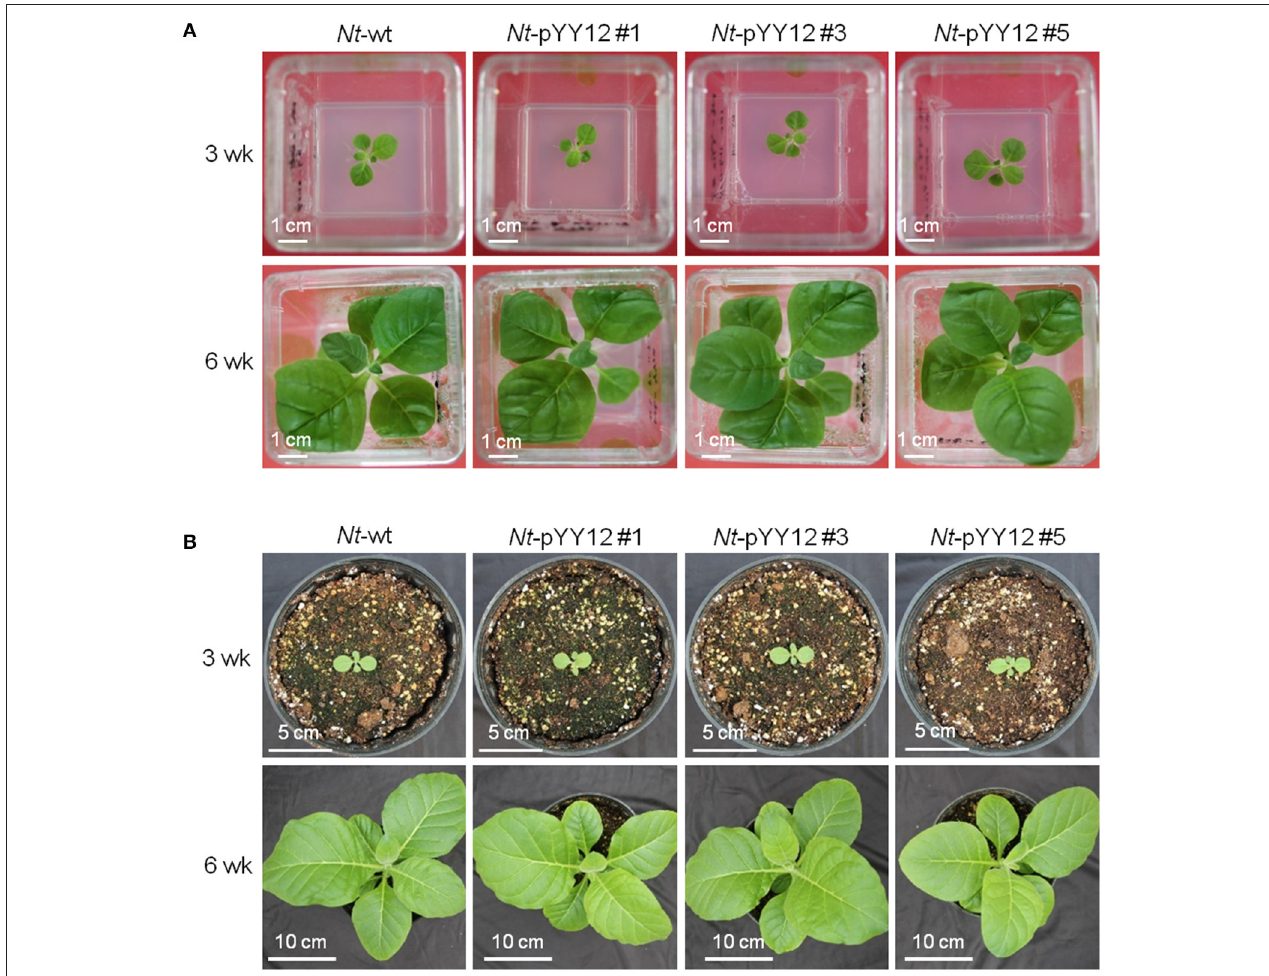
FIGURE 3 | Phenotypes of wild type and transplastomic plants. Plants are shown after (A) 3 weeks (upper panel) and 6 weeks (lower panel) of growth under heterotrophic conditions in sterile culture on sucrose-containing synthetic medium, (B) 3 weeks (upper panel) and 6 weeks (lower panel) of growth under photoautotrophic conditions in